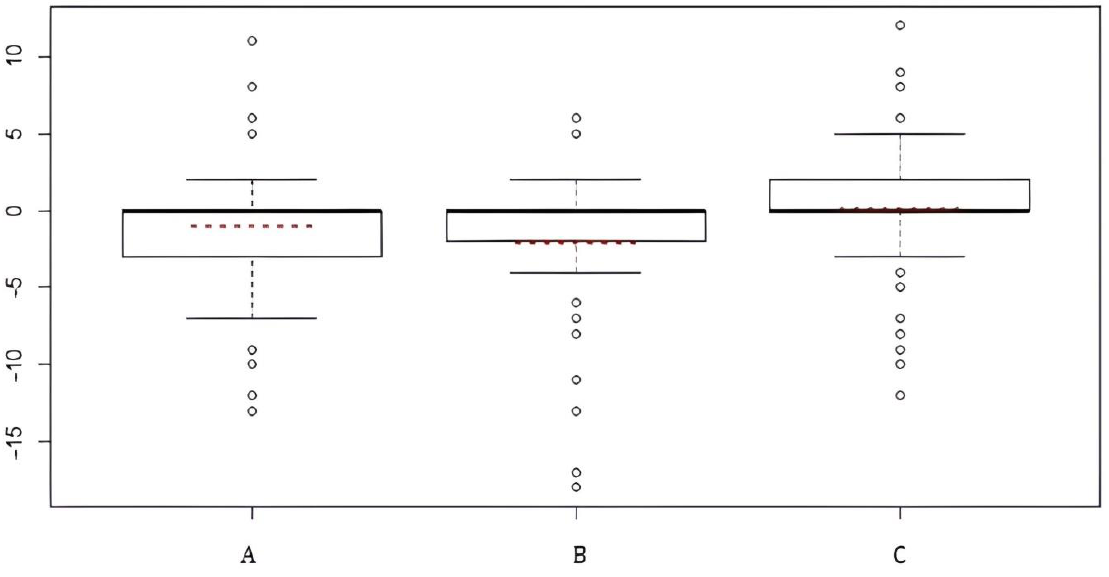
Figure 6. Differences in the total scores, by single monitoring technique, of EAT pre- and post-intervention. A = visual technique; B = intermittent nerve monitoring; C = continuous nerve monitoring. The dashed lines in red represent the mean of these differences, and the lines in bold represent both the median value and the modal value. The position of these three values indicates the concept of